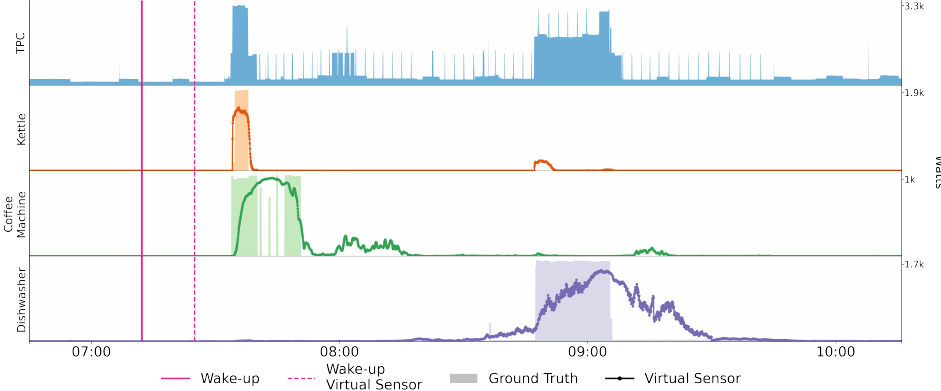
Figure 4. Disaggregation of TPC into different virtual sensors (scaled up for ease of